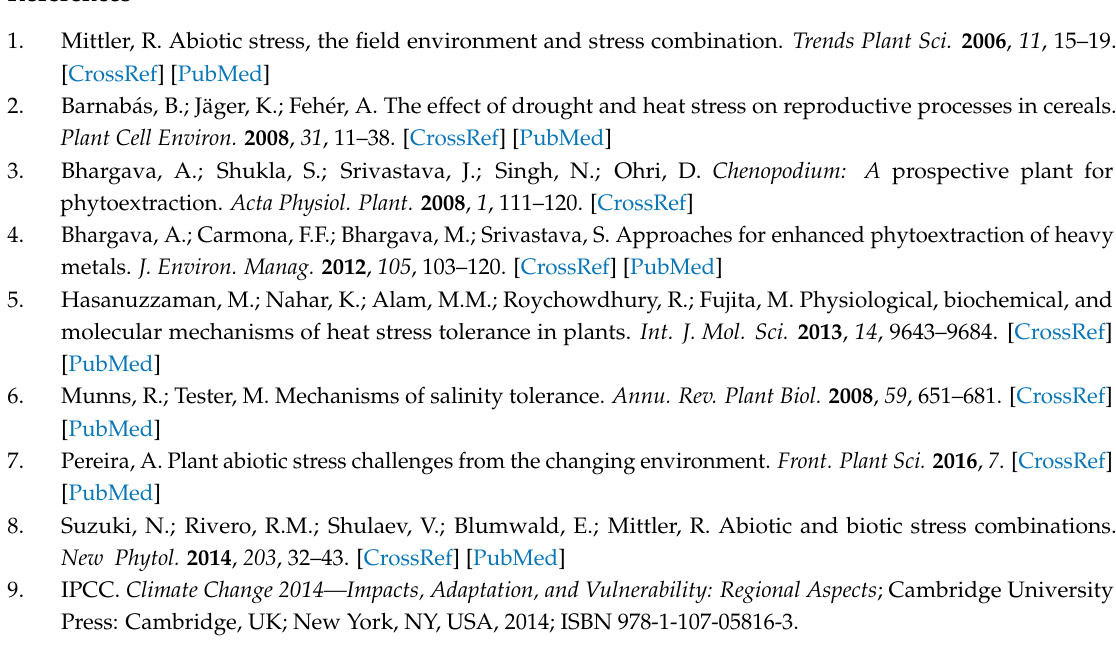
Table S1: Candidate genes involved in the salinity tolerance in